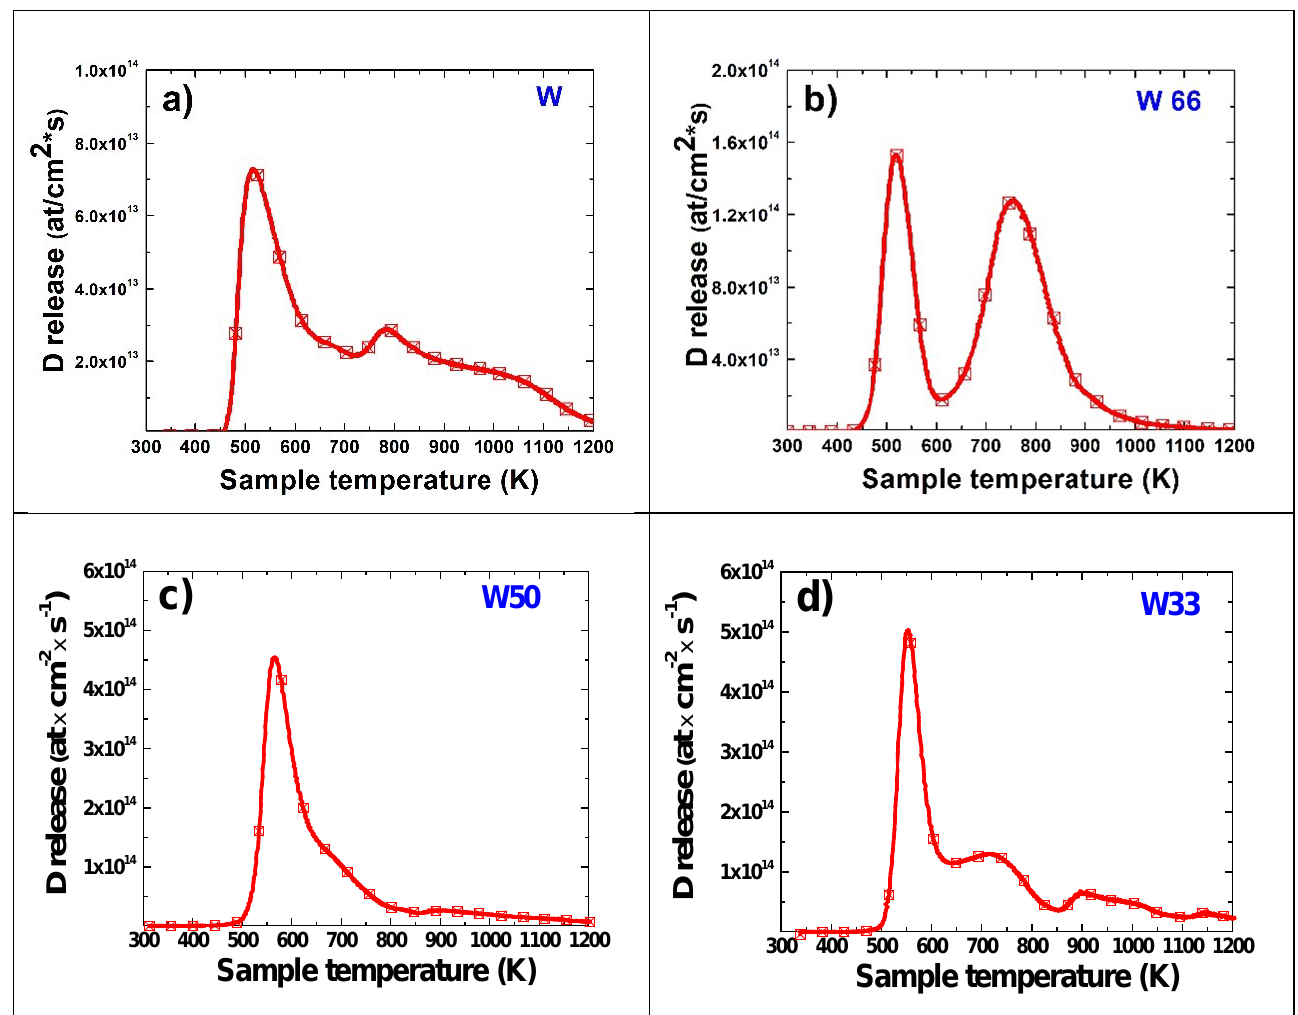
Figure 8. Deuterium release comparison for samples: ( a ) W, ( b ) W66, ( c ) W50, ( d ) W33.